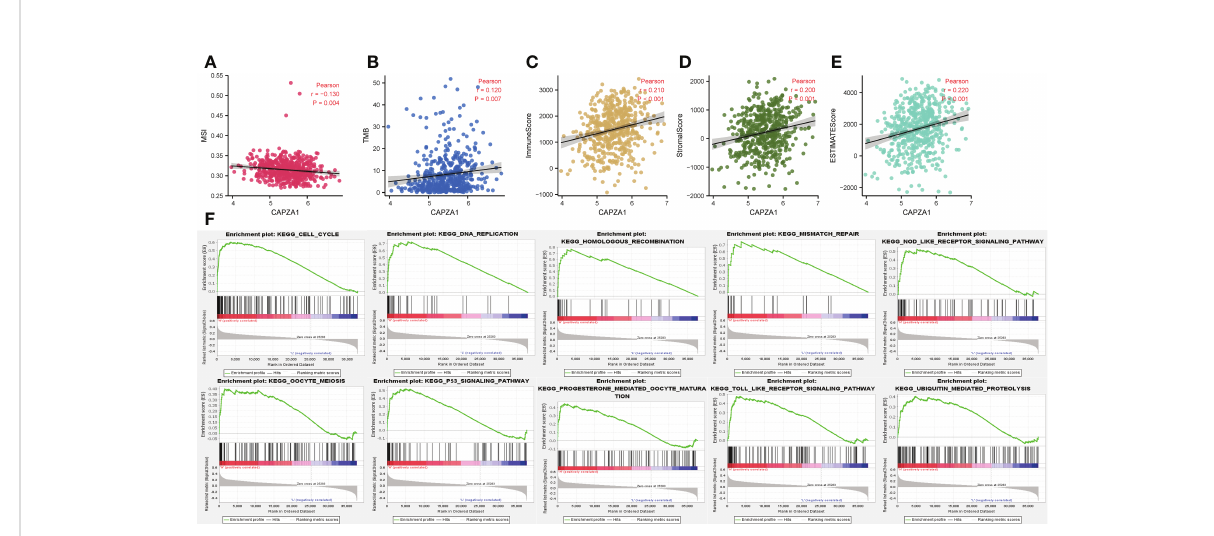
FIGURE 10 The correlation of CAPZA1 with immunotherapy and potential mechanisms. (A) Pearson correlation of CAPZA1 with MSI in LUAD. (B) Pearson correlation of CAPZA1 with TMB in LUAD. (C) Pearson correlation of CAPZA1 with ImmuneScore in LUAD. (D) Pearson correlation of CAPZA1 with StromalScore in LUAD. (E) Pearson correlation of CAPZA1 with estimateScores in LUAD. (F) Potential signaling